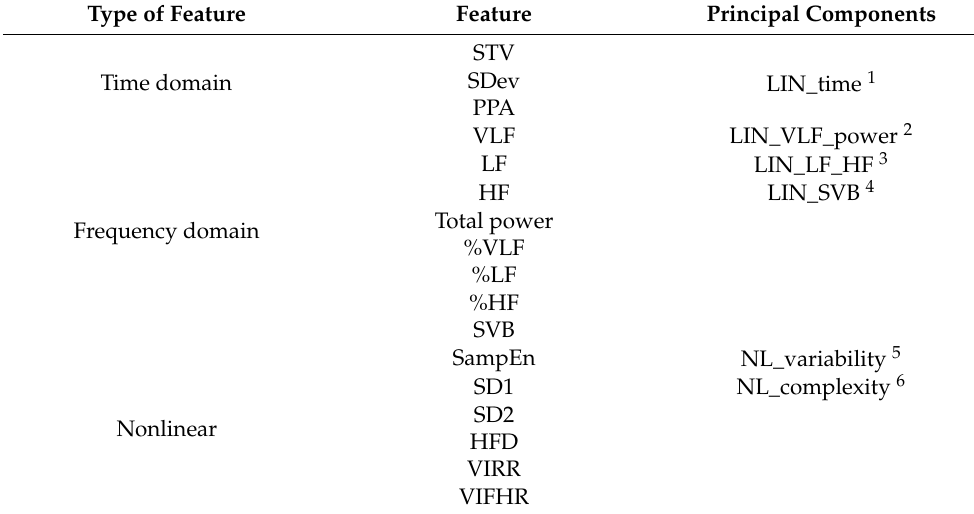
Table 4. Final subset of features obtained through the